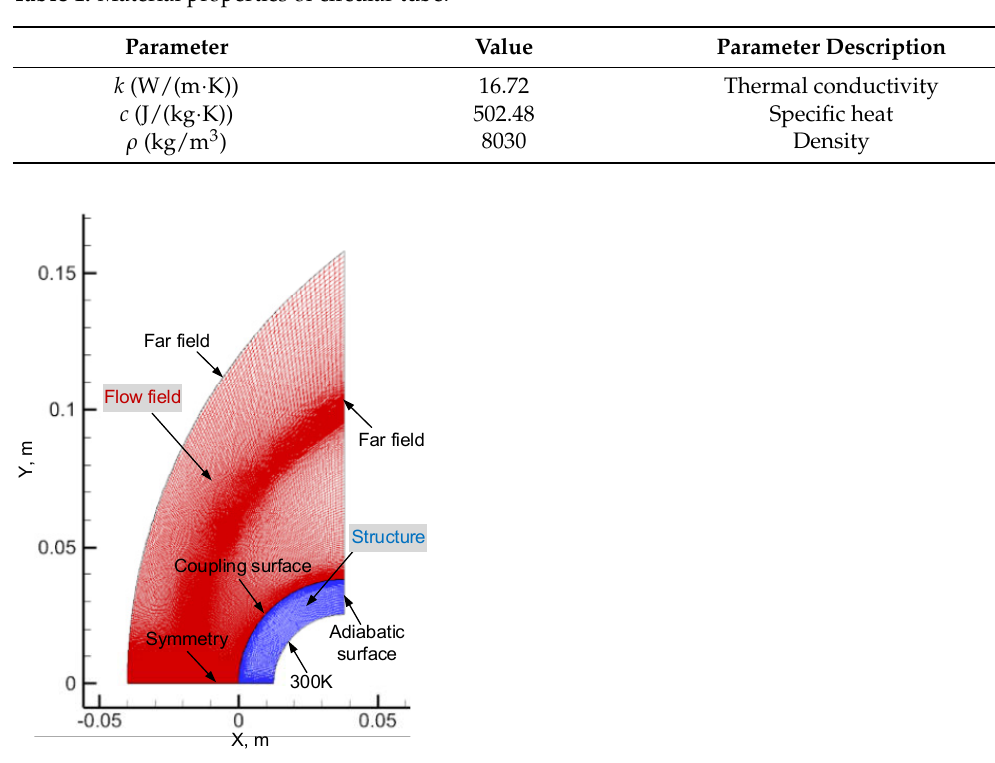
Table 1. Material properties of circular tube.